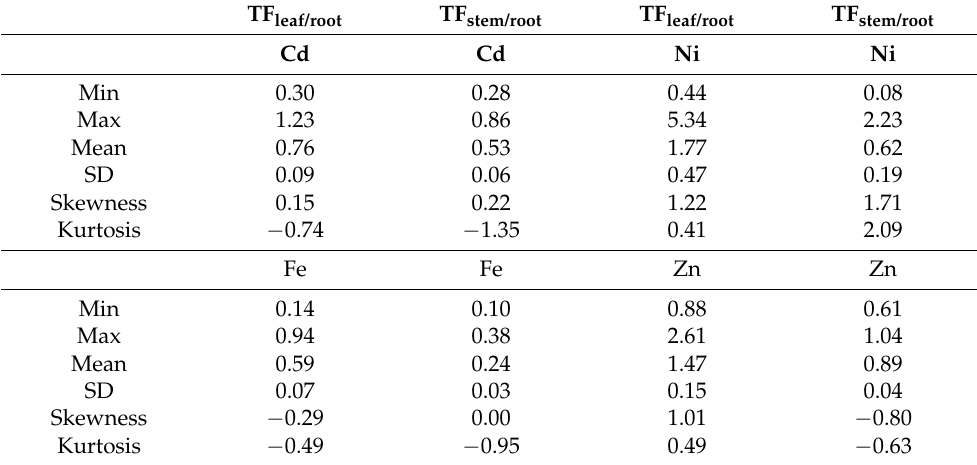
Table 7. Overall values of translocation factors (TF) of Cd, Fe, Ni, and Zn on the leaves, stems, and roots of Amaranthus viridis in Peninsular Malaysia (based on 11 sampling sites). TF leaf/root TF stem/root TF leaf/root TF stem/root Cd Cd Ni Ni Min 0.30